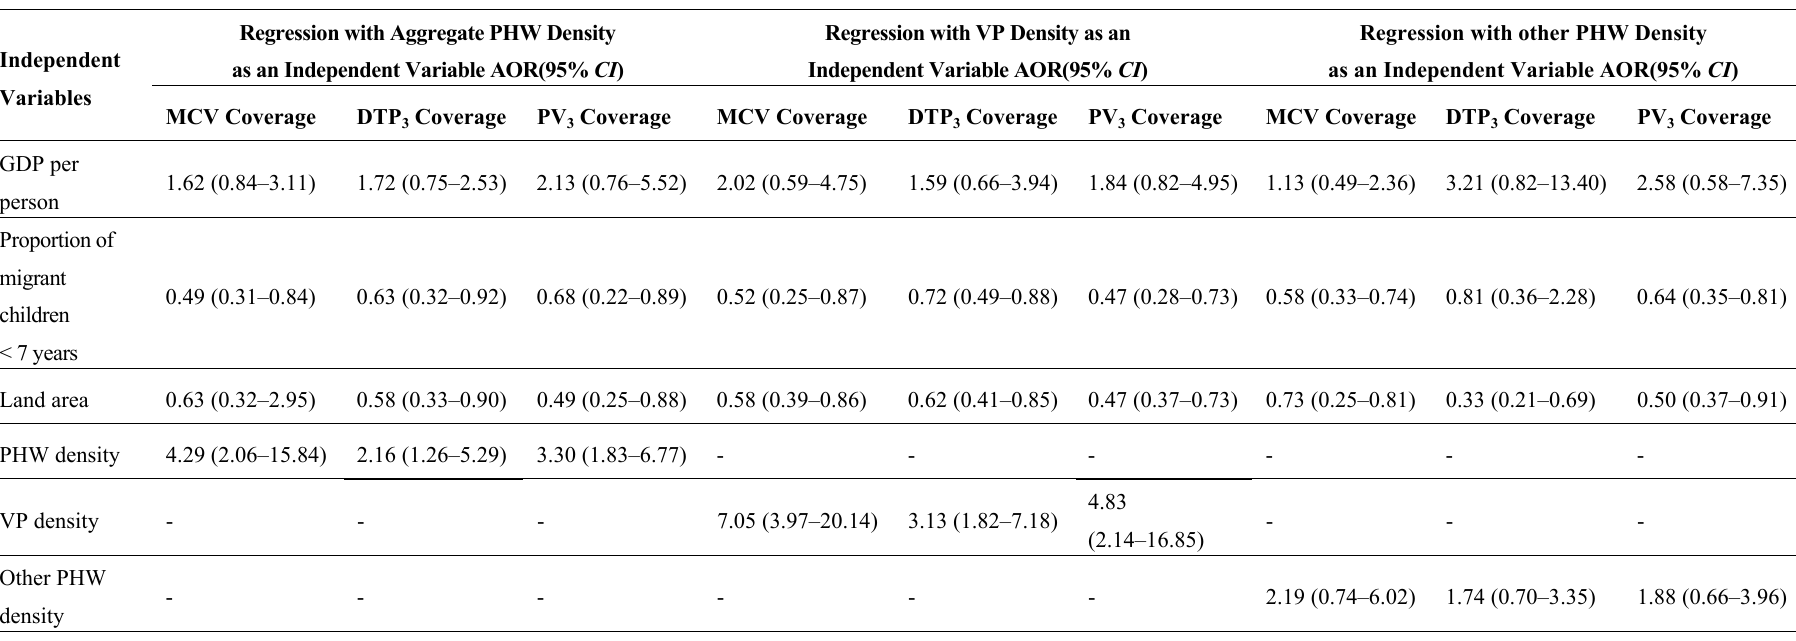
Table 3. Multivariable analysis on assessing the association between vaccination coverage and human resources of public